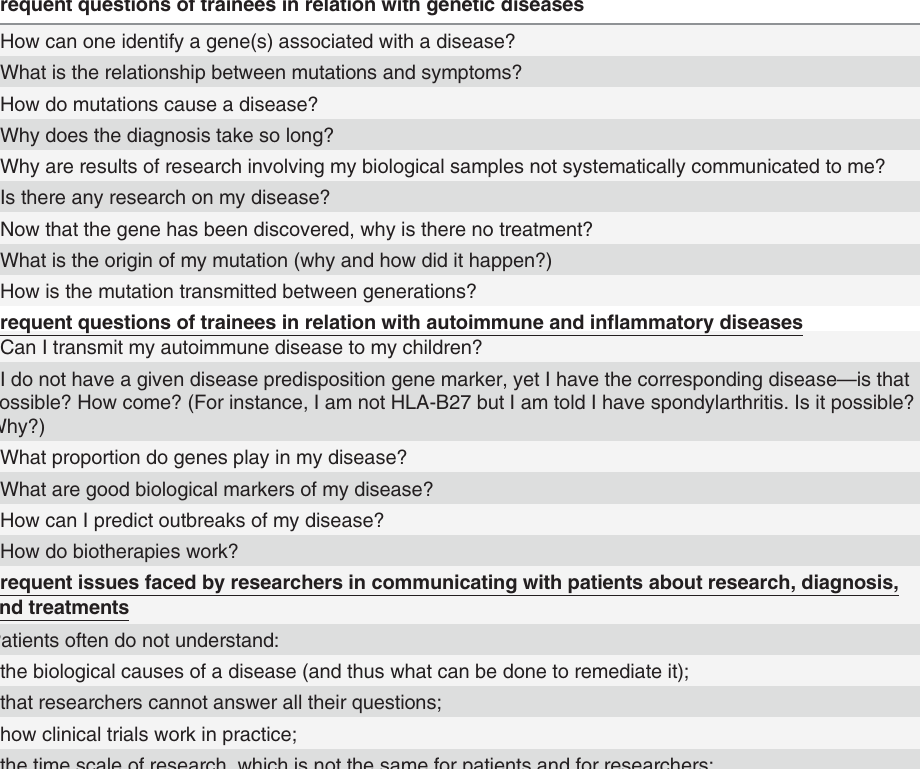
Table 2. Examples of common questions that trainees and experts would like us to clarify during the training session. Frequent questions of trainees in relation with genetic